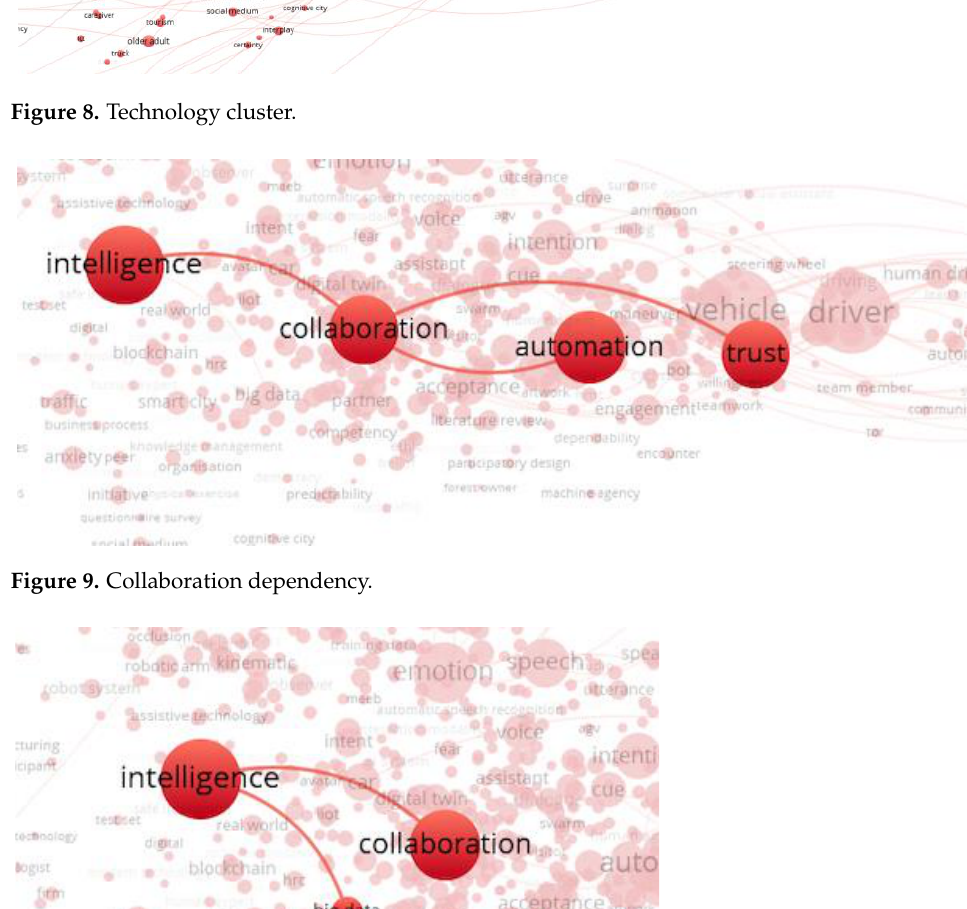
Figure 10. Intelligence dependency.